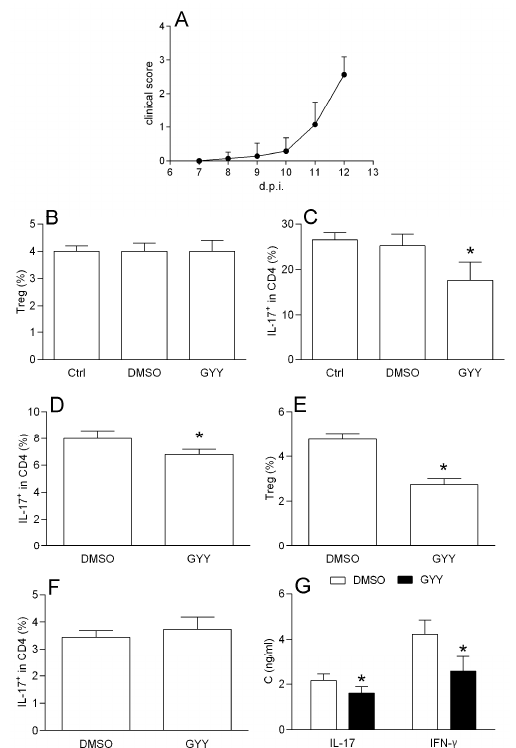
Figure 4. Effects of GYY4137 on rat spinal cord immune cells (SCICs). SCICs and DLNCs were isolated from rats immunized with rat spinal cord homogenate (SCH) + CFA at the peak of the disease or at day 7 post immunization, respectively. Clinical course of the EAE is presented ( A ). The percentage of the CD4 + CD25 + FoxP3 + cells (Treg), and the proportion of IL17 + among the CD4 + cells were determined by cytofluorimetry. The percentage of Treg was determined among the SCICs after 40 min cultivation in the presence of 200 µ M GYY4137 (GYY) or DMSO as the vehicle (DMSO) ( B ) The percentage of IL-17 + cells among the CD4 + cells was determined among the SCICs ( C ) or among the CD4 + T cells purified from the SCICs ( D ), after 40 min cultivation in the presence of 200 µ M GYY4137 (GYY) or DMSO as the vehicle (DMSO). The percentage of Treg was determined among the DLNCs after 40 min cultivation in the presence of 200 µ M GYY4137 (GYY) or DMSO as the vehicle (DMSO) ( E ). The percentage of IL-17 + cells among the CD4 + cells was determined among the DLNCs ( F ) after 40 min cultivation in the presence of 200 µ M GYY4137 (GYY) or DMSO as the vehicle (DMSO). In some experiments, the cultures without DMSO (Ctrl) were also performed ( B , C ). IL-17 and IFN- γ cytokine concentrations in the supernatants of 24 h cell cultures of SCICs treated with GYY4137 were determined by ELISA ( G ). Data are presented as the mean + standard deviation (SD) from three ( C , D , F ), four ( B , E ) or six ( A , G ) samples. * p < 0.05 refers to